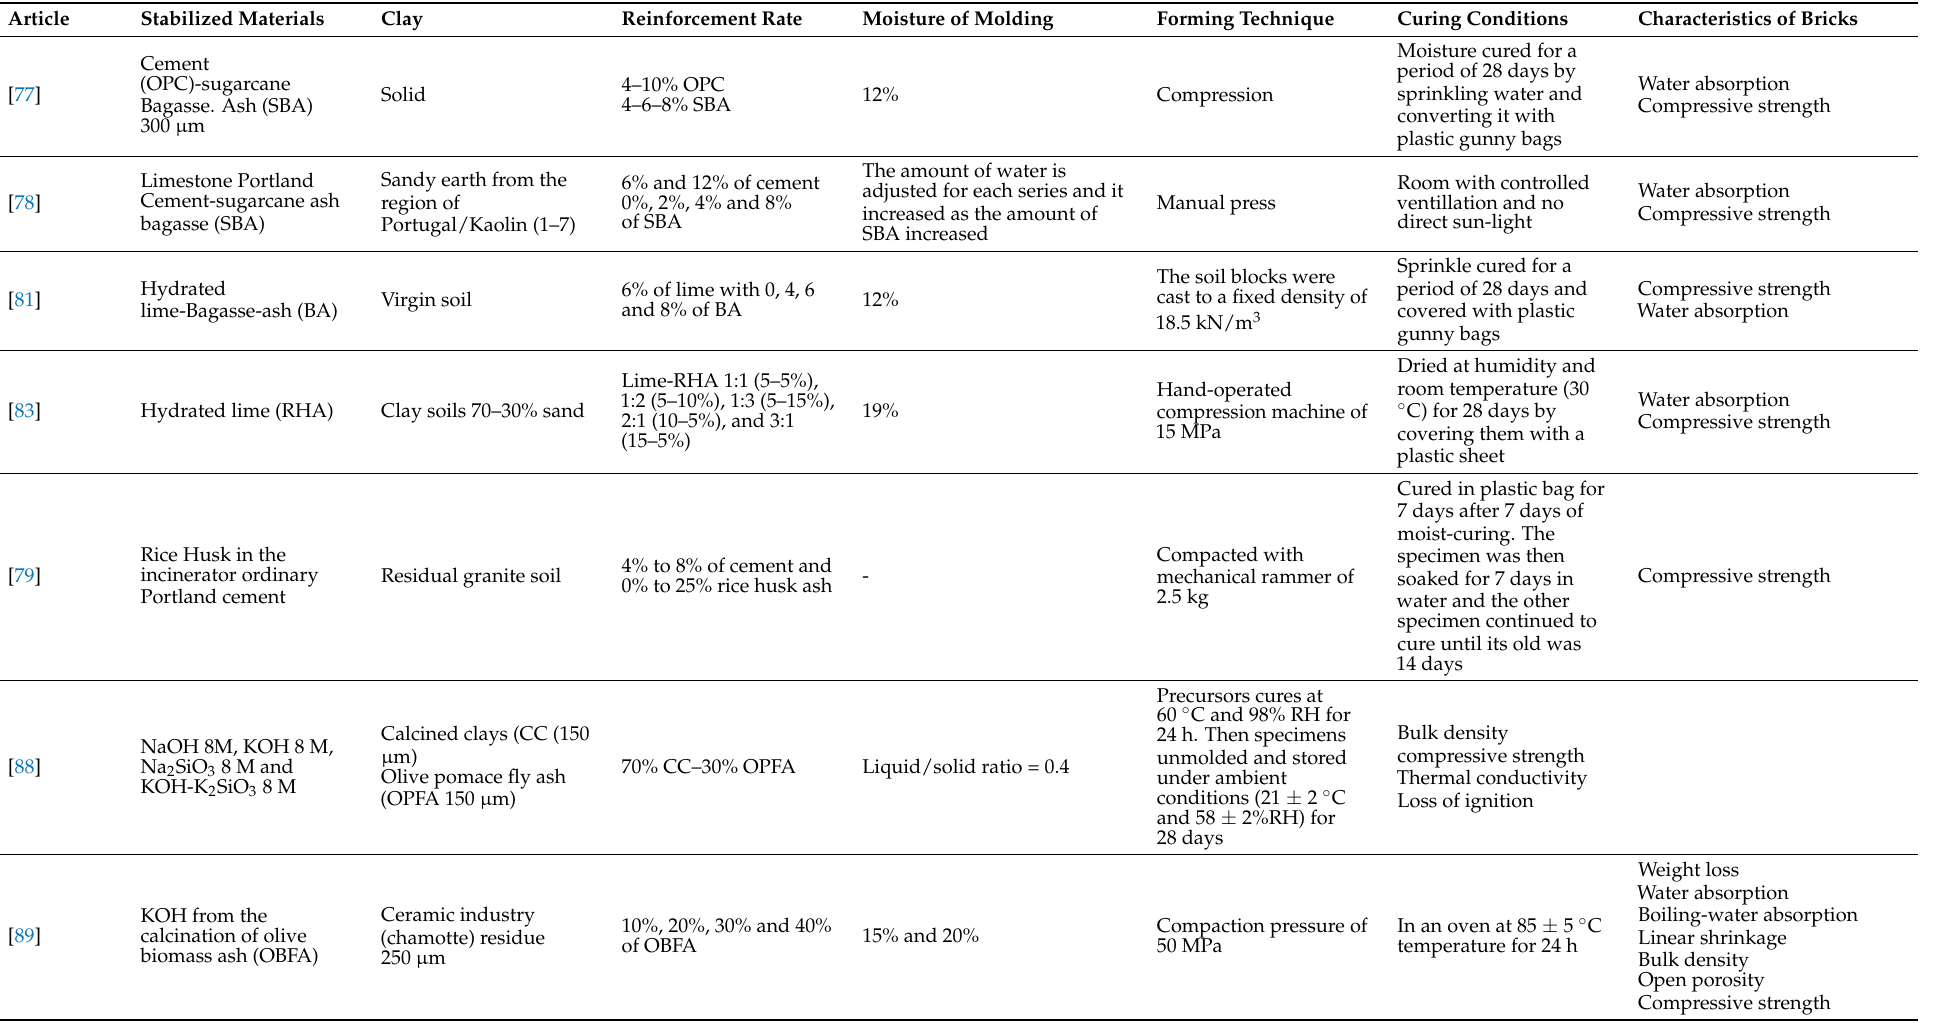
Table 3. Studies on the manufacturing of unfired bricks using waste lignocellulosic biomass